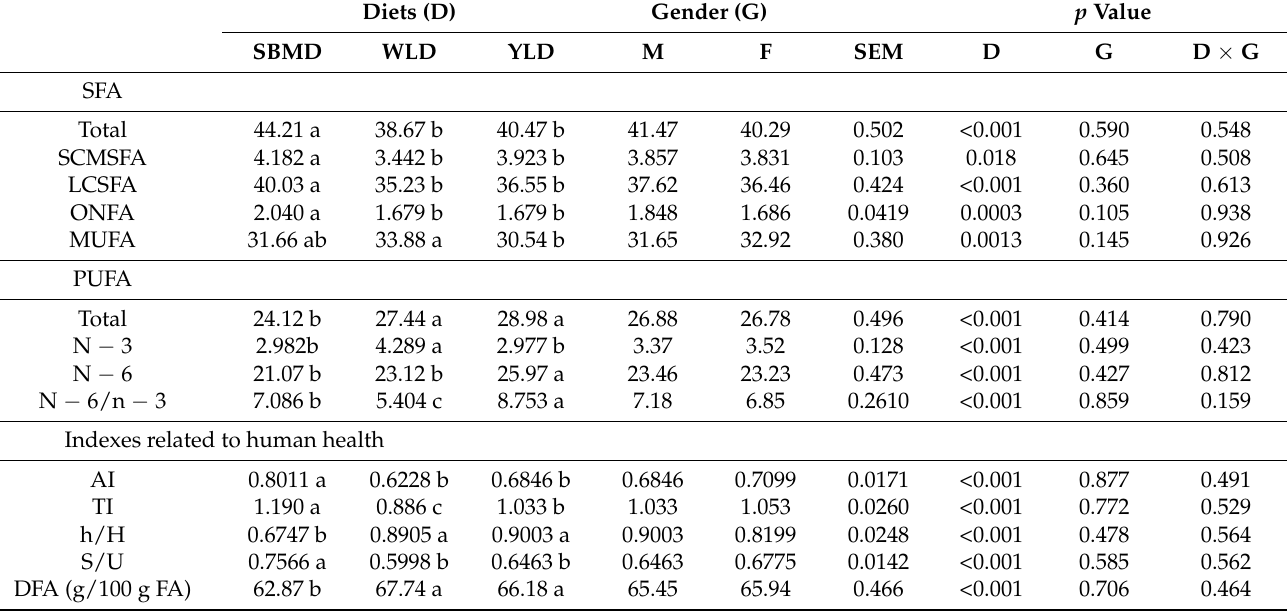
Table 5. Effects of diet and sex on mean contents (g/100 g FA) of fatty acid categories and